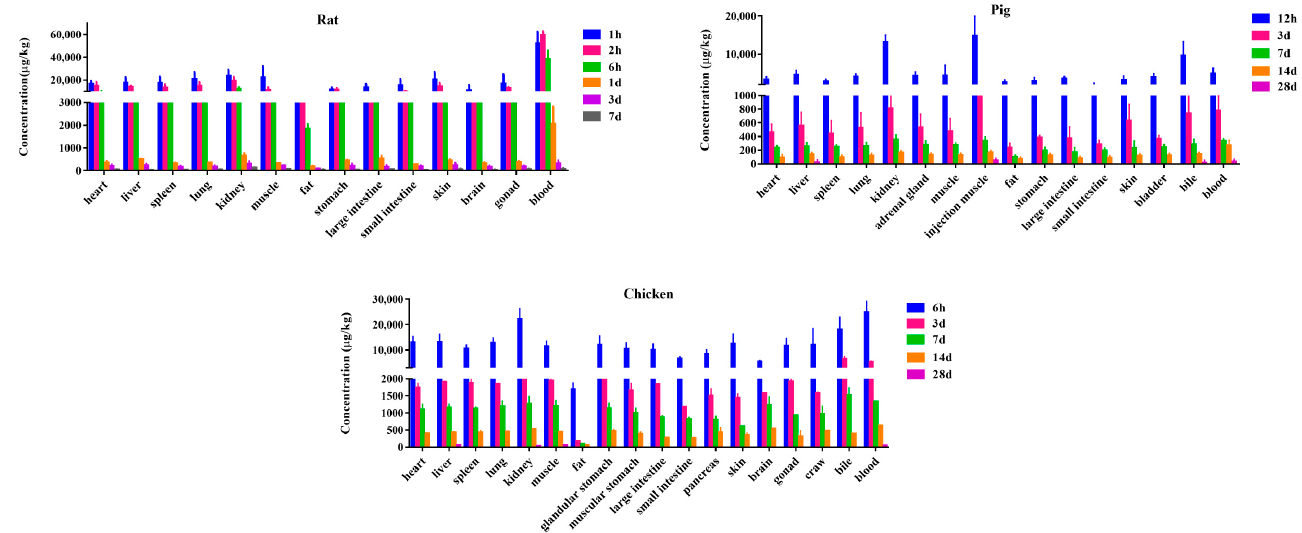
Figure 6. Tissue distribution of [ 3 H]-SMZ in rats, pigs and chickens. X axis: the main tissues of [ 3 H]-SMZ distribution, Y axis: the radioactivity concentration of [ 3 H]-SMZ ( µ g/kg), among which, rats lists the [ 3 H]-SMZ tissue distribution results at seven time points, pigs and chickens list [ 3 H]-SMZ tissue distribution results at five time